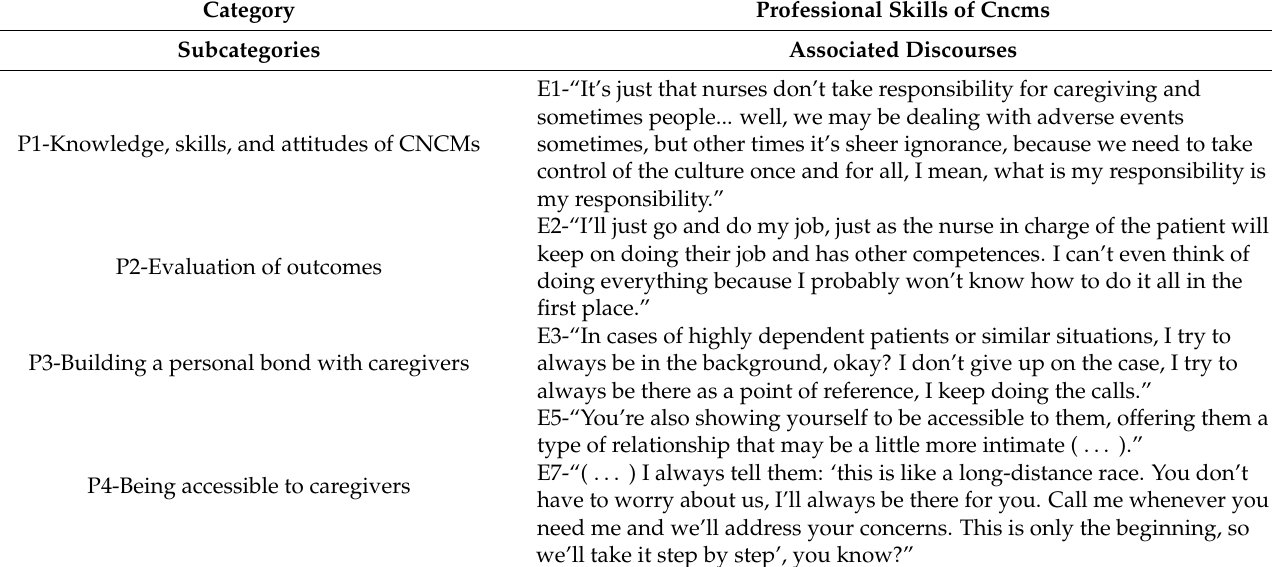
Table 3: In this table, we can see the most significant discourses to understand the meaning of the subcategories associated with the CAT-P, Professional Skills of CNCMs.